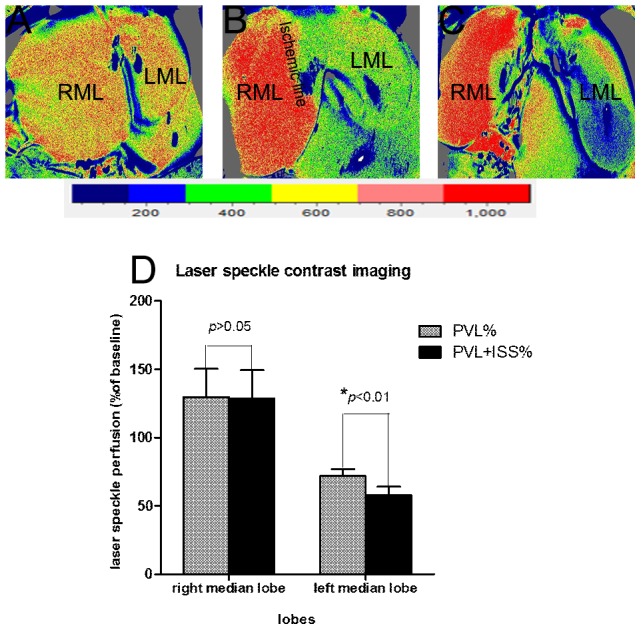
Laser speckle contrast imaging (LSCI).Typical hepatic flux perfusion images obtained from LSCI of the RML and the LML are shown: 5 min after laparotomy (A), 5 min after PVL (B) and 5 min after PVL+ISS (C). The microcirculation of the right median and left median lobes measured by LSCI after PVL and PVL+ISS was expressed as a percentage of the baseline value (D). There was a significant difference in the left median lobe before and after ISS (*p<0.01), but no significant difference was observed in the right median lobe (p>0.05).